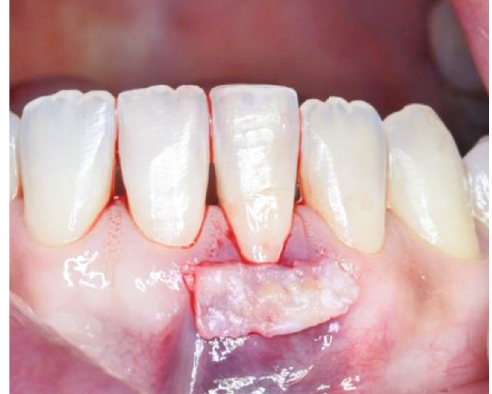
Figure 10: The suture Figure 8 with nonpolymerized resin.